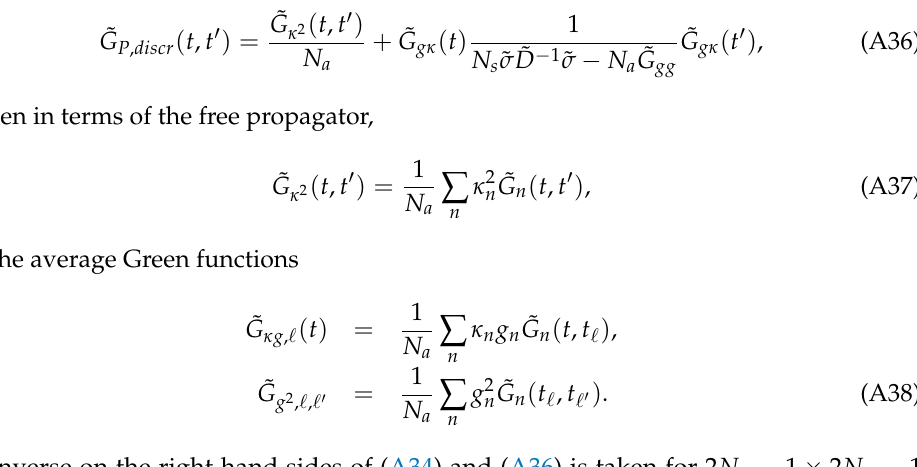
The inverse on the right hand sides of (A34) and (A36) is taken for 2 N m − 1 × 2 N m − 1 matrices (indices are